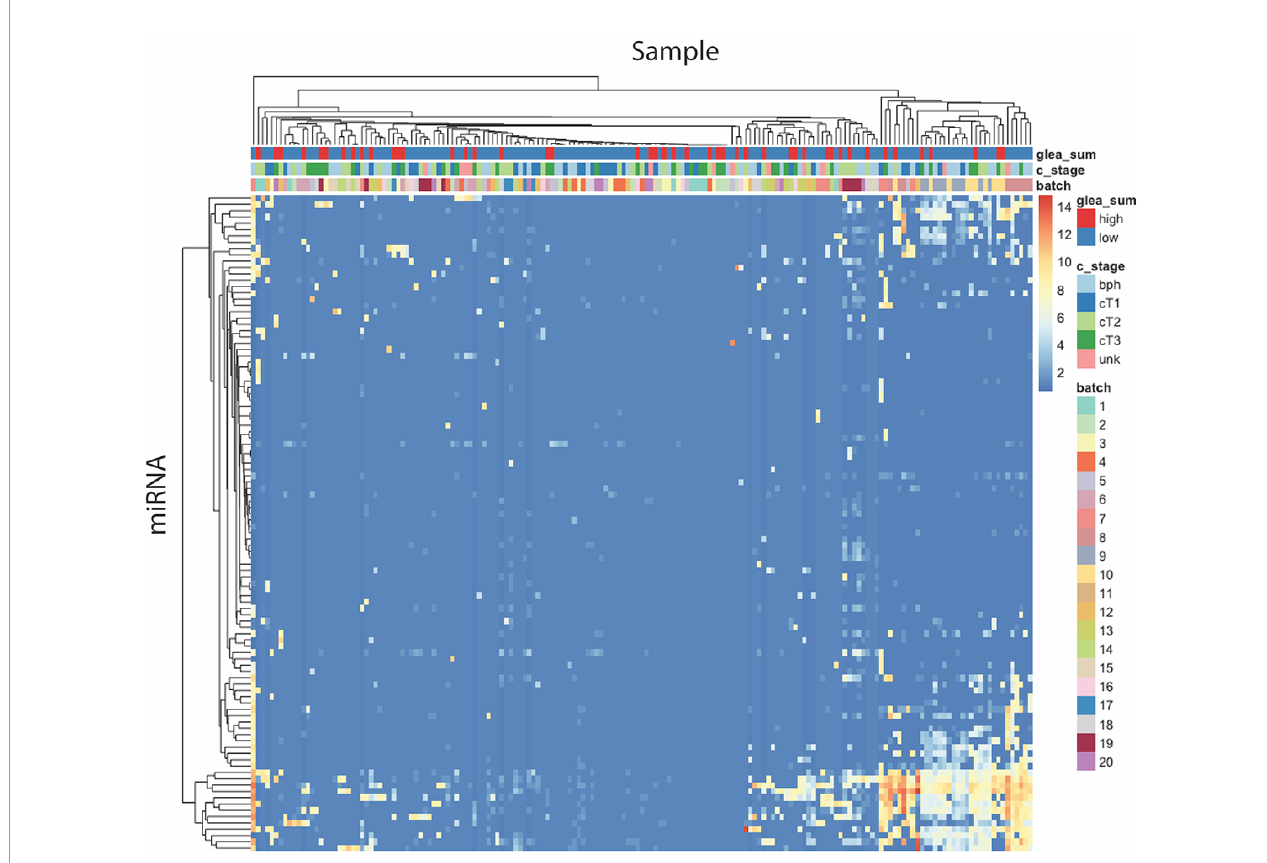
FIGURE 5 | Unsupervised clustering of miRNAs expression revealed no discernible patterns between clinical parameters and